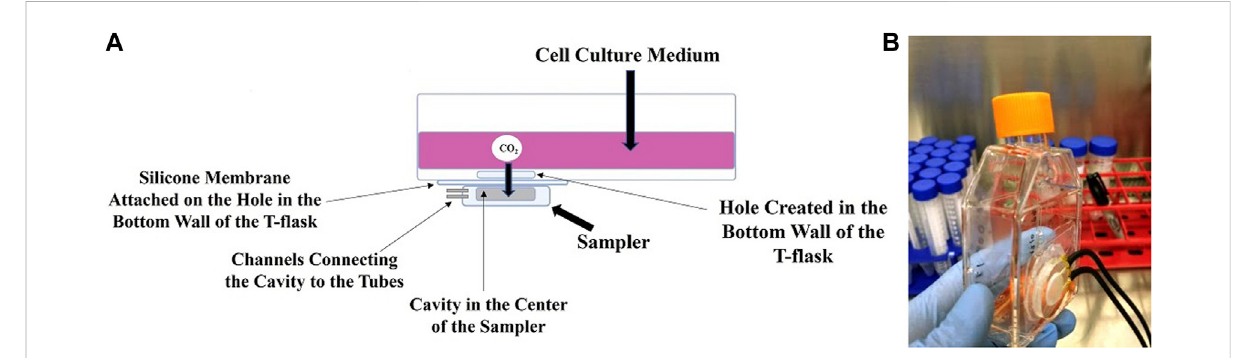
The schematic (A) and photograph (B) of the modi fi ed T- fl ask. The CO 2 gas from the cell culture medium diffuses through the silicone membrane into the sampler, where it is collected and transferred to a CO 2 sensor via black gas-impermeable tubing.